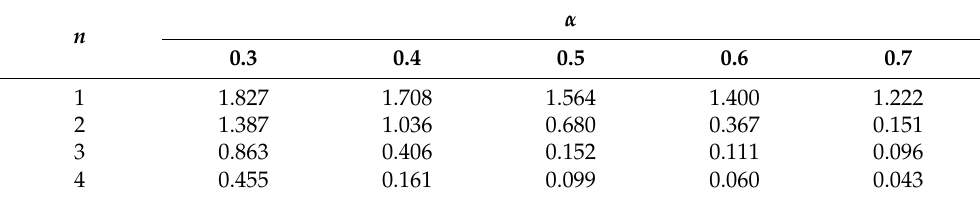
Table 3. Synchronization reduction factors C δ ( n ) with different contact ratios α .